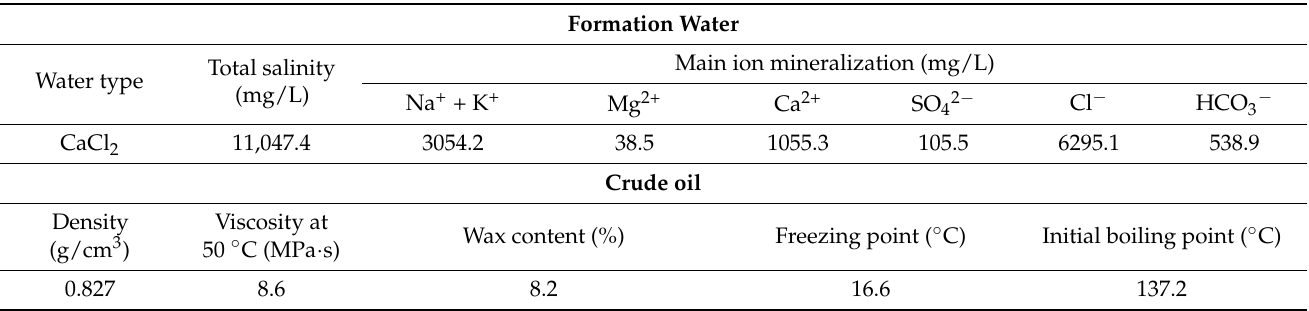
Table 3. For imbibition replacement, heavy water (D 2 O) with a density of 1.056 g/cm 3 was selected. Table 3. Fluid property parameters of the Baikouquan Formation reservoir. Formation